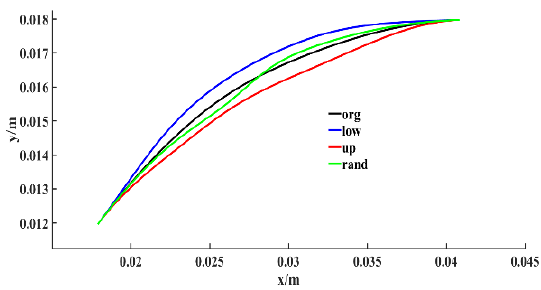
Figure 7. The bound and the random sample of the camber line during optimization.